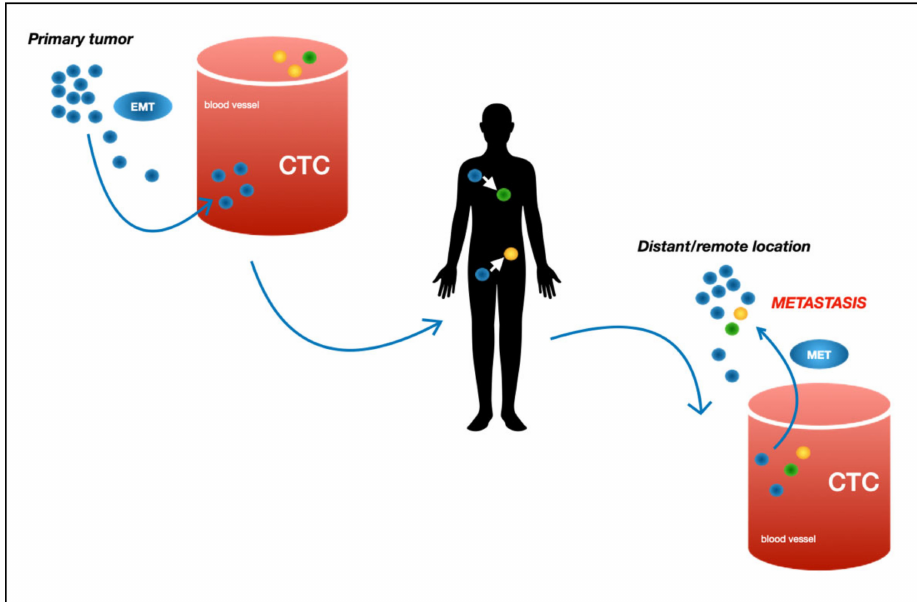
Figure 1. Schematic illustration of metastasis formation by circulating tumor cell. CTC = circulating tumor cells; EMT = epithelial-to-mesenchymal transition; MET = mesenchymal-to-epithelial transition